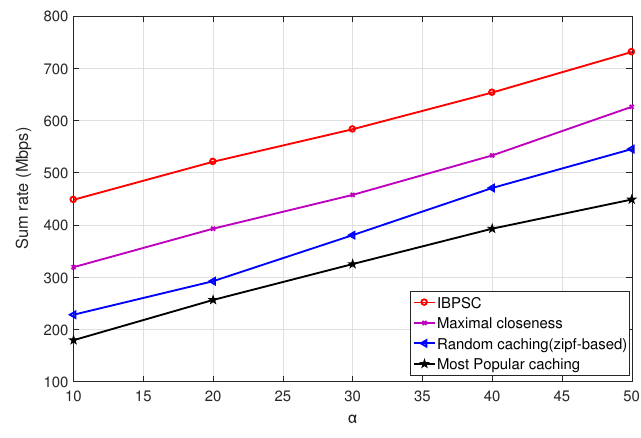
Figure 4. Sum rate vs. Poisson parameter α